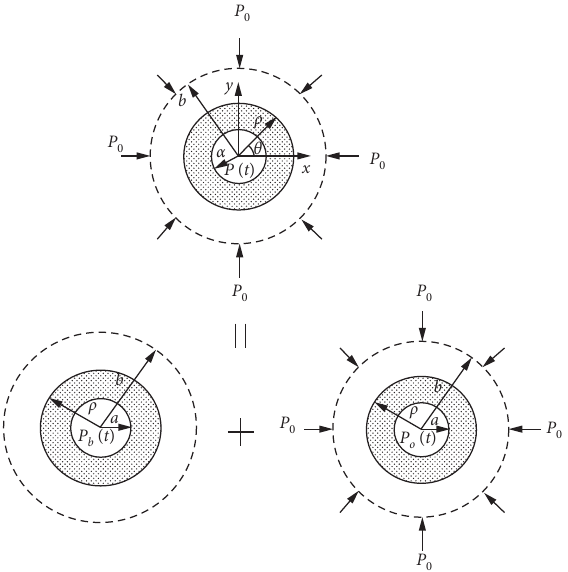
Figure 6: Forces on circular tunnel under dynamic unloading.